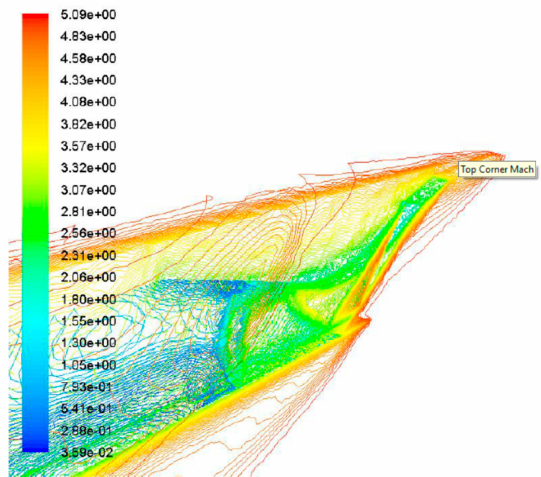
Figure 15. Alternate view of 3D Mach